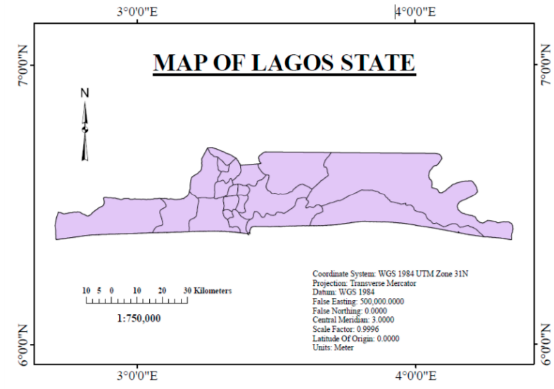
Figure 1. Map of Lagos